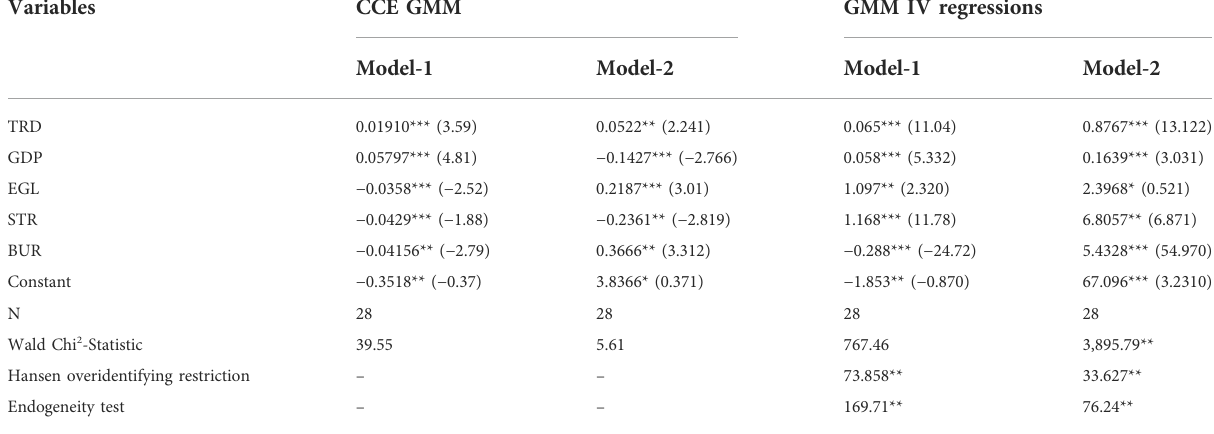
TABLE 7 Robustness check with CCE GMM and IV